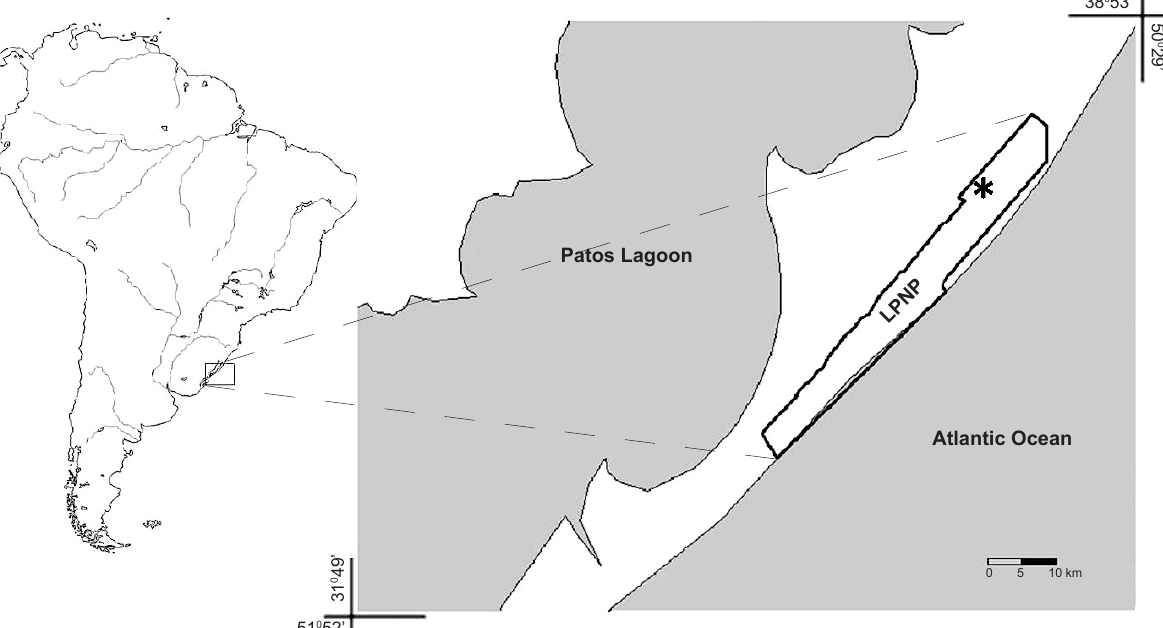
Figure 1. Map showing the present record of Austrolebias wolterstorffi in Lagoa do Peixe National Park, Rio Grande do Sul, southern